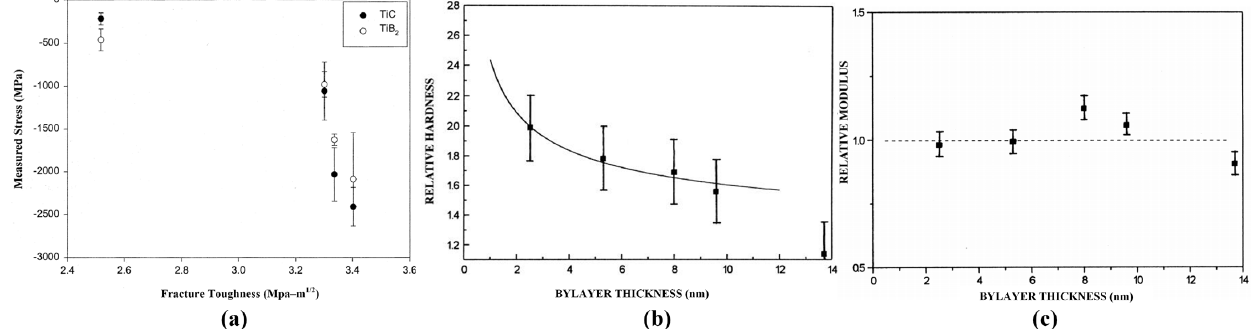
Figure 6. Ion beam machining of carbide-based UHTCMCs. ( a ) Measured stress (MPa) as a function of average fracture toughness (MPa·m 1/2 ) for the 14 μm thick TiB 2 /TiC multilayer coatings deposited on WC–6wt.%Co–0.3wt.%TaC by argon ion beam assisted. Reprinted/adapted with permission from Ref. [125]. Copyright 2003, Elsevier. ( b ) relative hardness and ( c ) elastic modulus of TiC/Mo multilayered films as a function of bilayer thickness. Reprinted/adapted with permission from Ref. [126]. Copyright 2000, Elsevier.